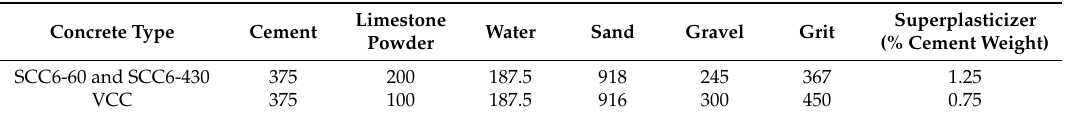
Table 1. Concrete formulation per m 3 . SCC: Self-compacting concrete; VCC: Vibrated conventional